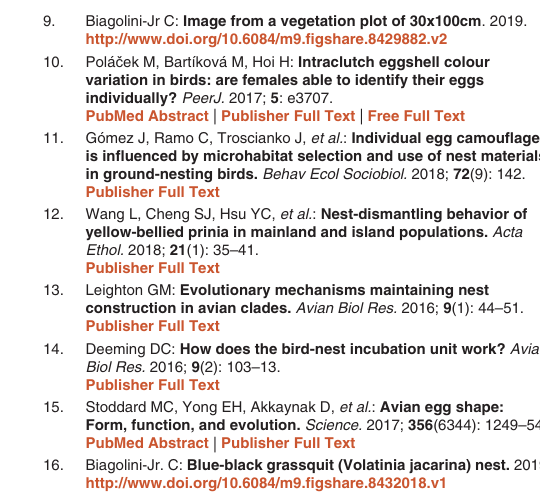
Figshare: Blue-black grassquit (Volatinia jacarina) nest. https://doi.org/10.6084/m9.figshare.8432018.v1 16